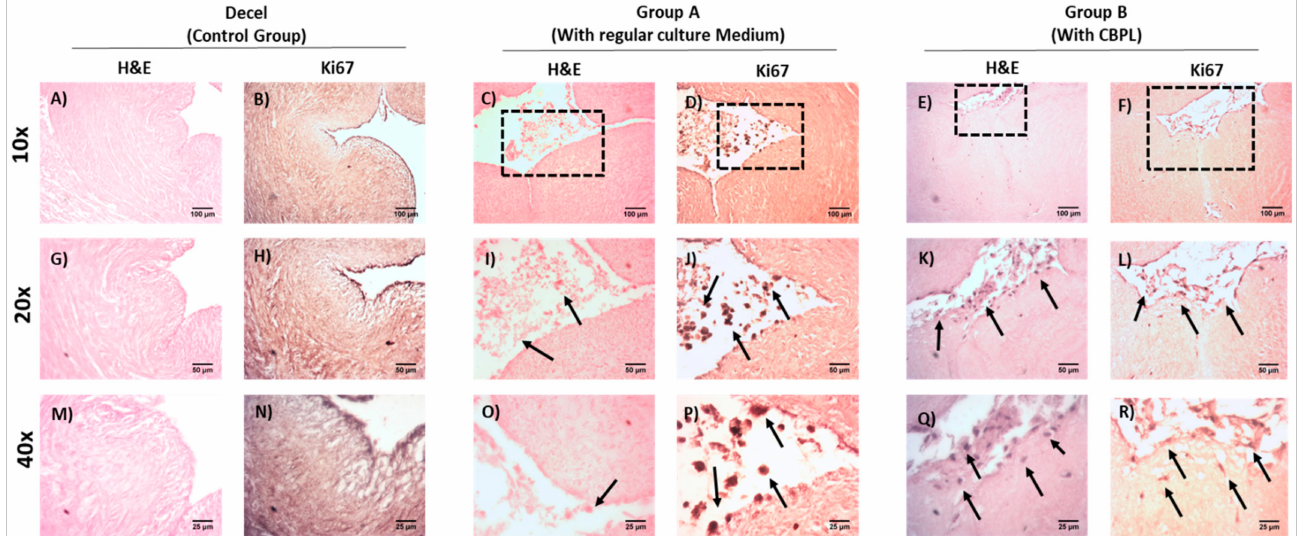
Figure 9. Histological analysis of repopulated vascular grafts with WJ-MSCs P3, located in the tunica intima. Decellular- ized hUAs stained with H&E ( A , G , M ). Repopulated hUAs of group A ( C , I , O ) and group B ( E , K , Q ) stained with H&E. Immunohistochemistry against Ki67 in decellularized hUAs ( B , H , N ), and repopulated hUAs of group A ( D , J , P ) and group B ( F , L , R ). Images ( A – F ) presented with original magnification 10 × , scale bars 100 µ m. Images ( G – L ) presented with original magnification 20 × , scale bars 50 µ m. Images ( M – R ) presented with original magnification 40 × , scale bars 25 µ